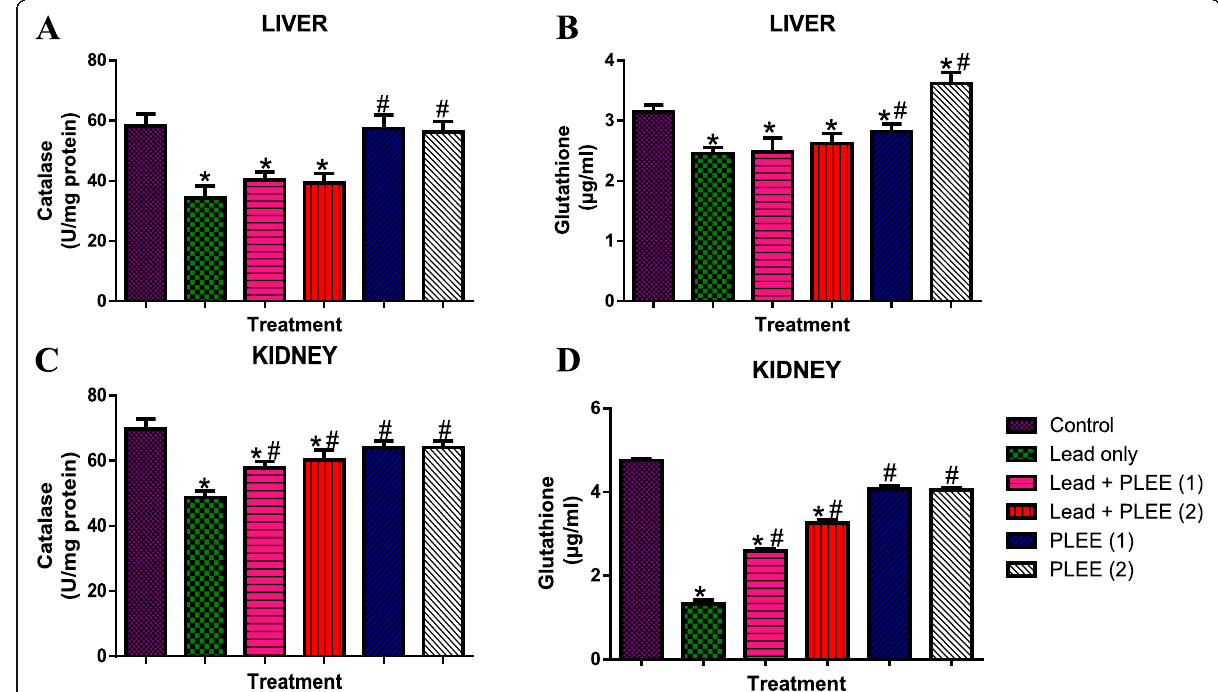
Fig. 3 Changes in the levels of catalase and glutathione in hepatorenal toxicity induced with lead acetate and treated with PLEE in Wistar rats. Results are represented as Mean ± SD ( n = 5). *- Significantly different from the negative control group, #- significantly different from Lead-only group ( p <